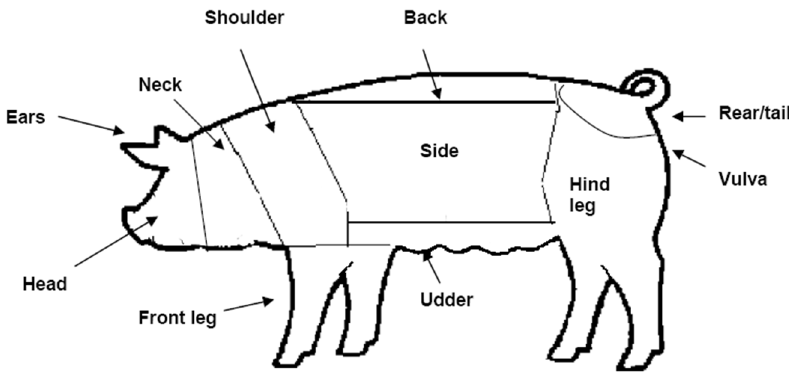
Figure 4. The animal’s body was divided in to 11 areas as illustrated. Each area on both sides was assessed for skin lesions (Score = 0 to 3).